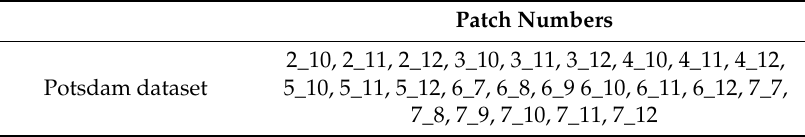
Table 1. The patch numbers of labeled data utilized for the ISPRS